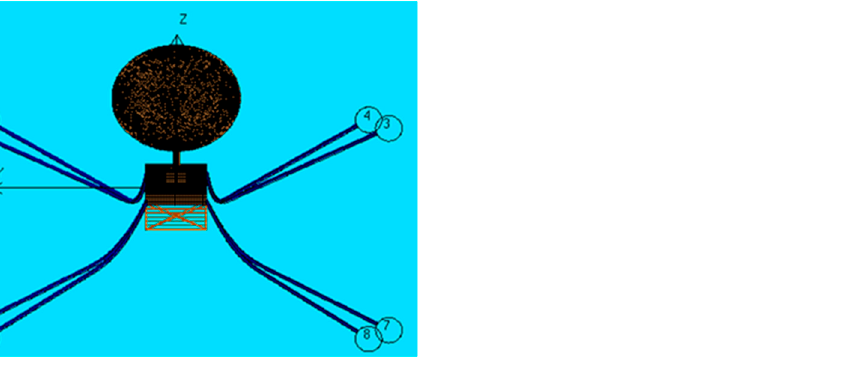
Figure 7. The mesh model of the numerical simulation simplified, where mooring line 1 to 8 are marked.